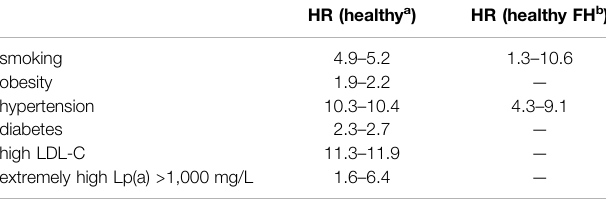
TABLE 4 | Impact of individual risk factors on cardiovascular risk (hazard